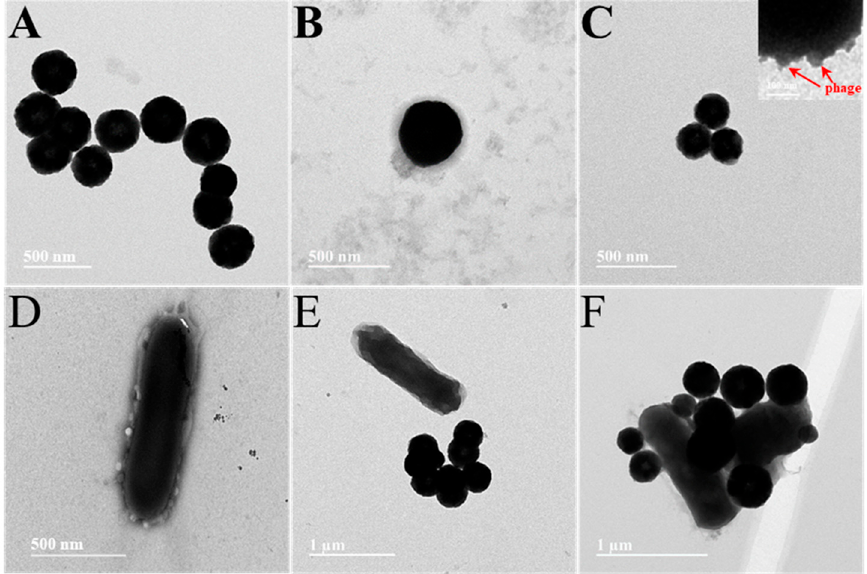
Figure 1. ( A ) pure MBs, ( B ) PDDA-coated MBs, ( C ) M-P1, ( D ) P2-S labelled S.T ( E ) pure MBs captured S.T, ( F ) M-P1 @S.T@P2-S sandwich complex.